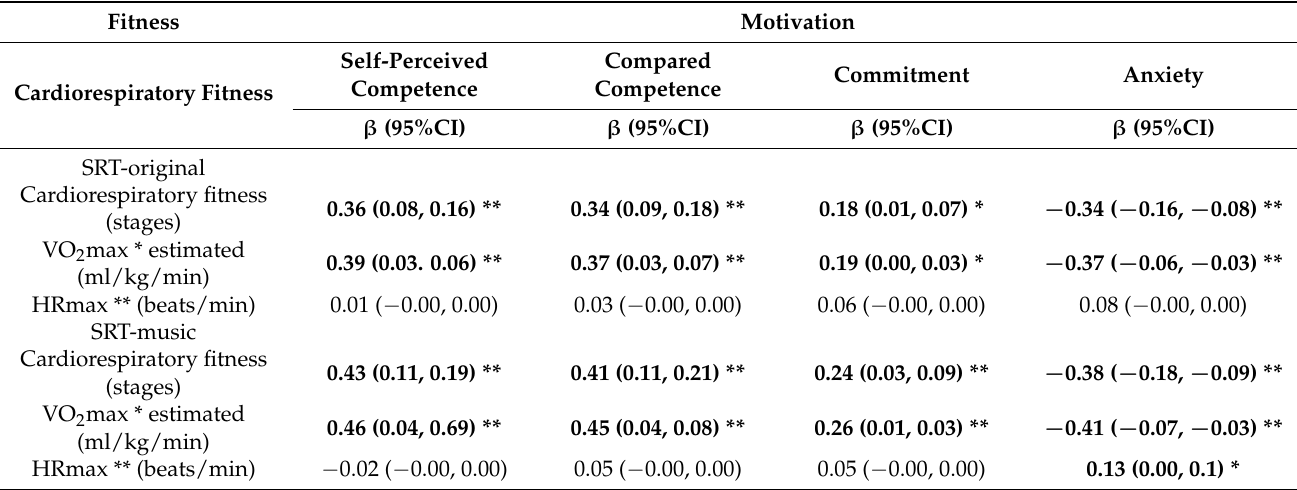
Table 2. Associations between cardiorespiratory fitness and achievement motivation